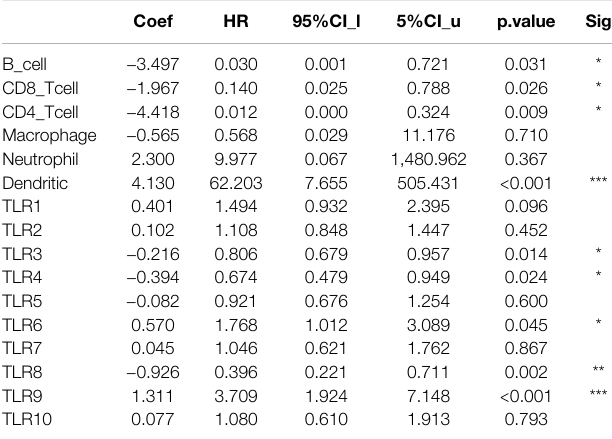
TABLE 3 | Cox proportional hazard model of TLRs and 6 kinds of immune cells in fi ltration in KIRC patients. Coef HR